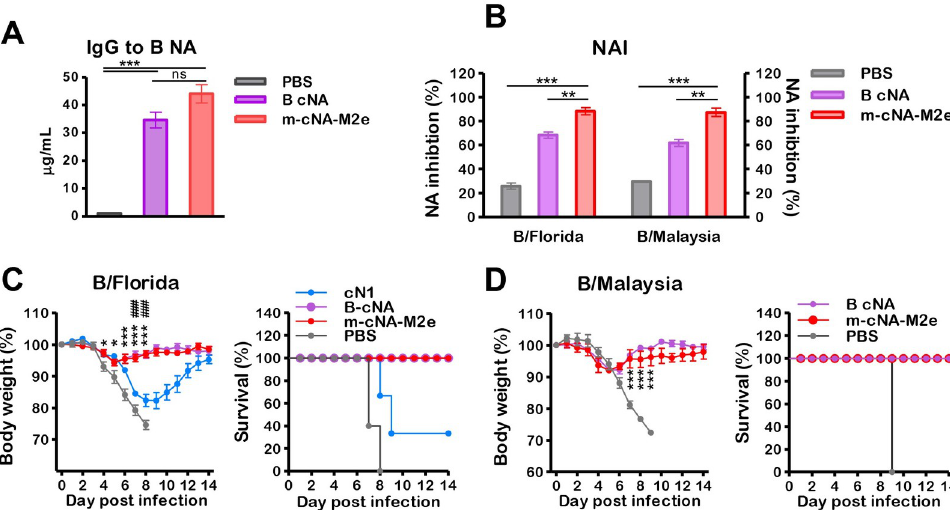
Fig 4. Vaccination with m-cNA-M2e VLP induces cross protection against influenza B viruses. BALB/c mice (n = 10 per group) were intramuscularly prime-boost immunized with m-cNA-M2e VLP (10 μ g) or B cNA VLP (3 μ g). (A) IgG antibodies specific for flu B NA protein (B/Florida/4/2006) as determined by ELISA. (B) NA inhibition activities against B/Florida/4/2006 and B/Malaysia/2056/2004 viruses in 40-fold diluted boost immune sera by ELLA. (C) Protection against B/Florida/4/2006 (2xLD 50 ). (D) Protection against B/Malaysia/2056/2004 (3xLD 50 ). The VLP vaccine dose and groups are the same as in the Fig 2 legend. The statistical significances were performed with one-way ANOVA with Tukey’s Multiple Comparison test and indicated as � ,# P < 0.05; �� ,## , P < 0.01; ��� ,### , P < 0.001 (compared among the m-cNA-M2e and PBS or monomeric cN control